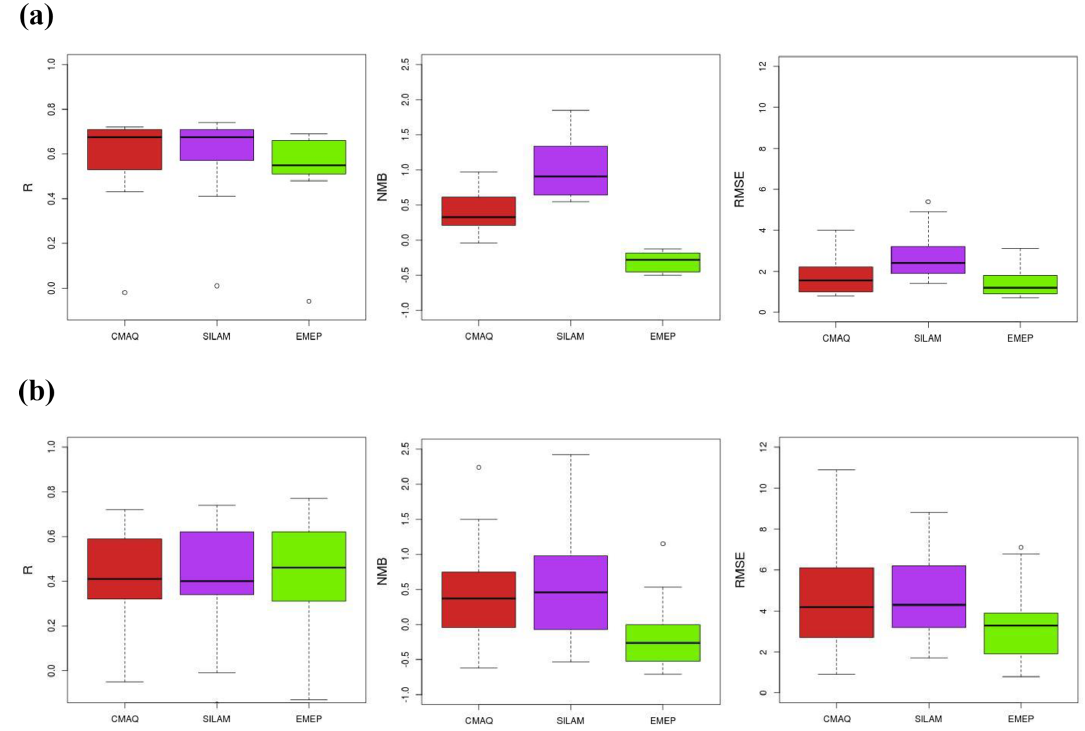
Figure 5. Comparison of statistical indicators for SO 2 daily means (in the order R , NMB and RMSE) between three CTMs at (a) rural background stations and (b) urban background stations. Outliers shown as small